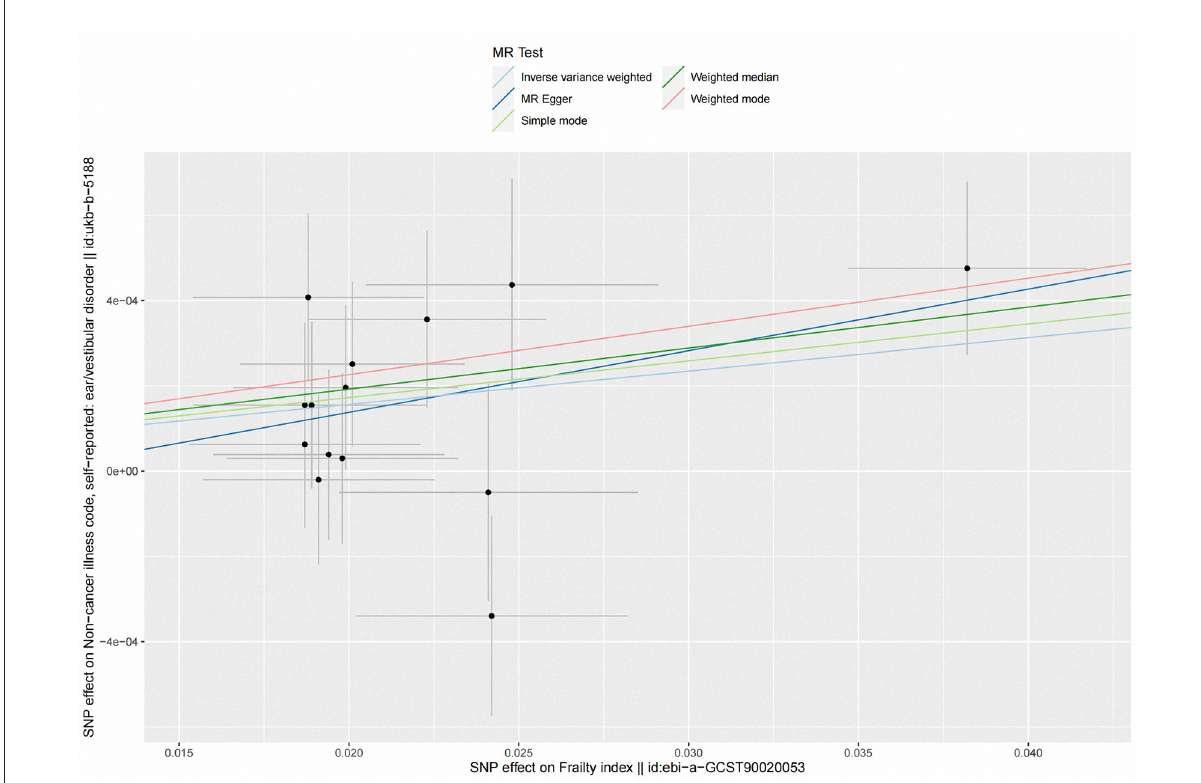
FIGURE2 Scatter plot of the effects of genetic variants on frailty index and vestibular disorders. The slopes of the solid lines denote the magnitudes of the associations estimated from the MR analyses. MR, Mendelian randomization; SNP, single-nucleotide